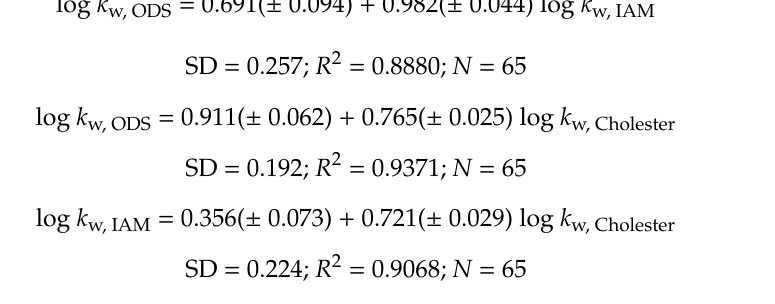
Table 2. Parameters of the Soczewi´nski-Wachtmeister’s equation obtained for various columns. Compound Tested